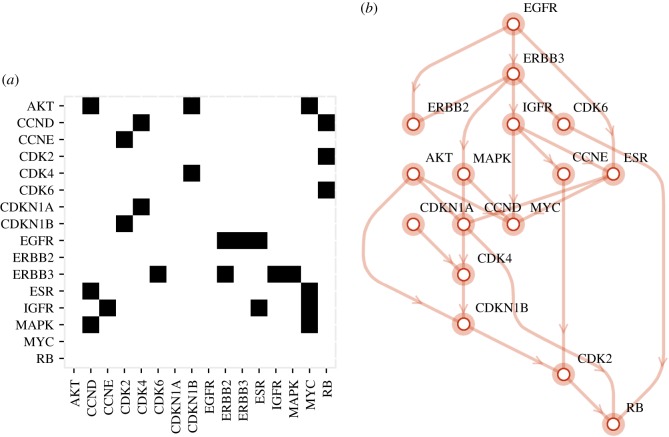
Adjacency matrix (a) of an ERBB signalling network (b).